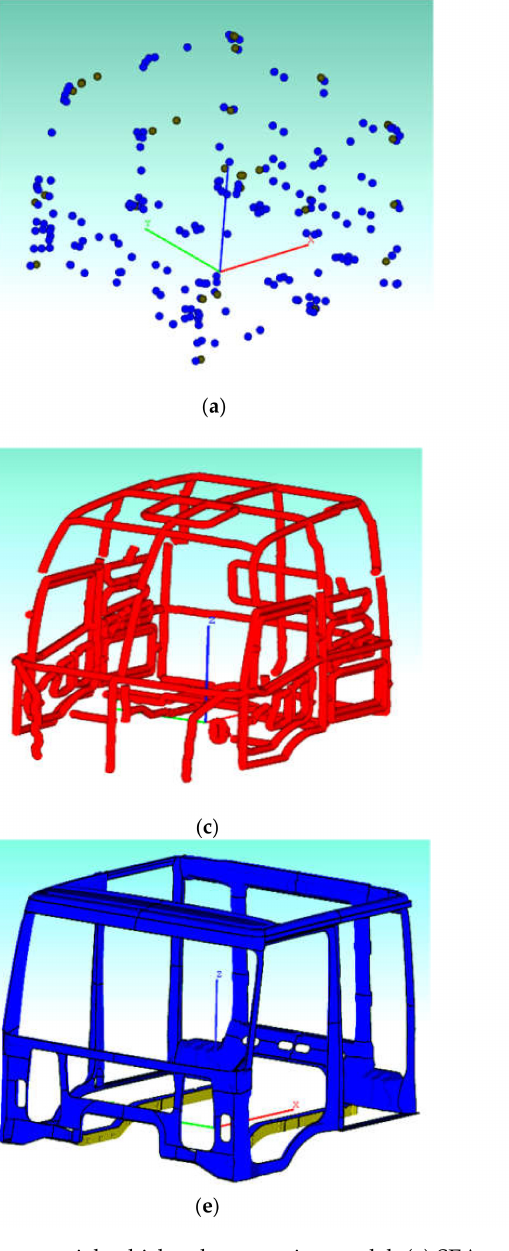
Figure 3. Commercial vehicle cab connection model. ( a ) SEA point connection model; ( b ) SEA point-line connection model; ( c ) SEA line connection model; ( d ) FE wire connection model ( e ) hybrid line connection model; ( f ) SEA surface connection and hybrid surface connection